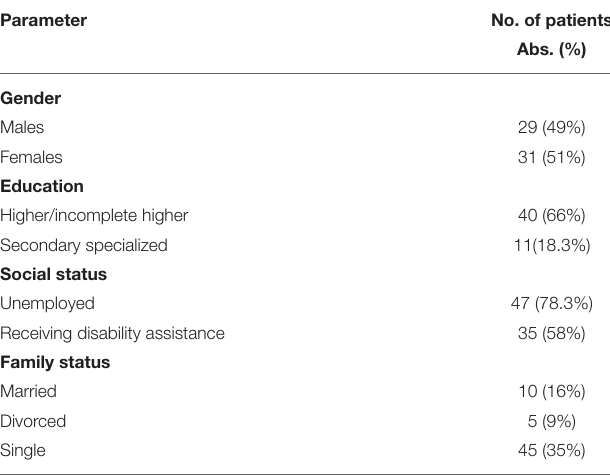
TABLE 2 | Patient disposition by cariprazine daily dose at each of 4 weeks of